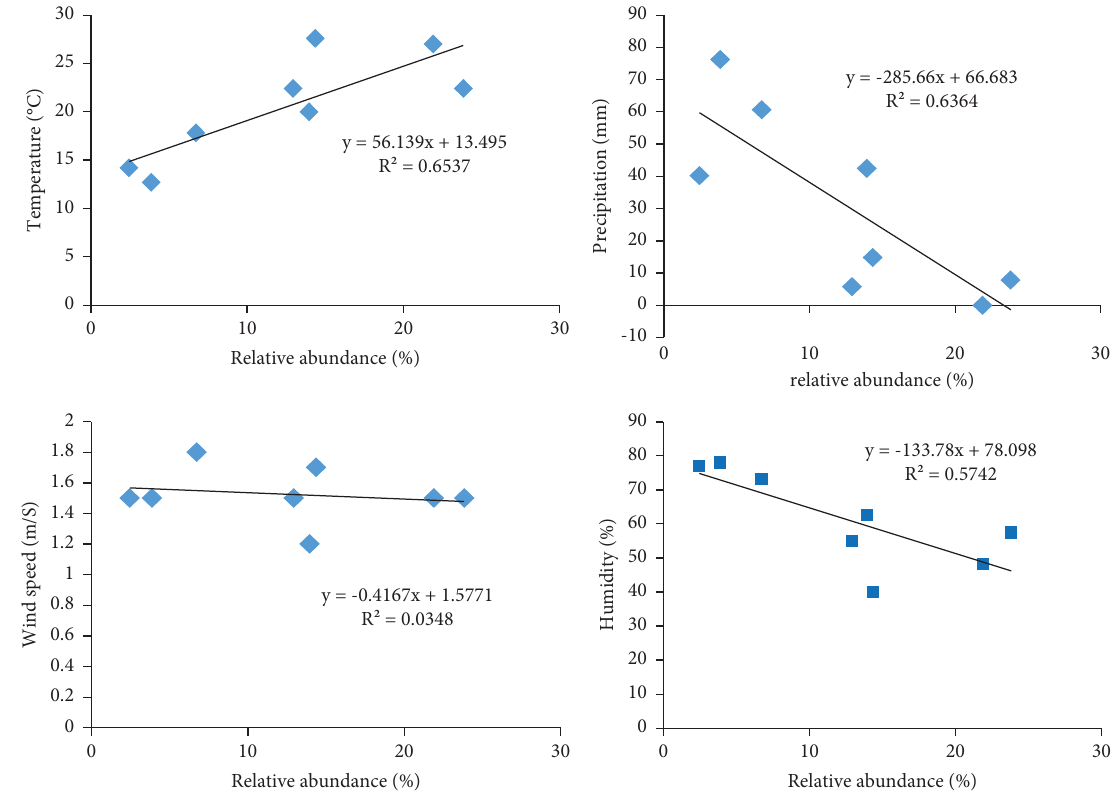
Figure 4: Tere is a correlation between the abundance of sandfies and climatic